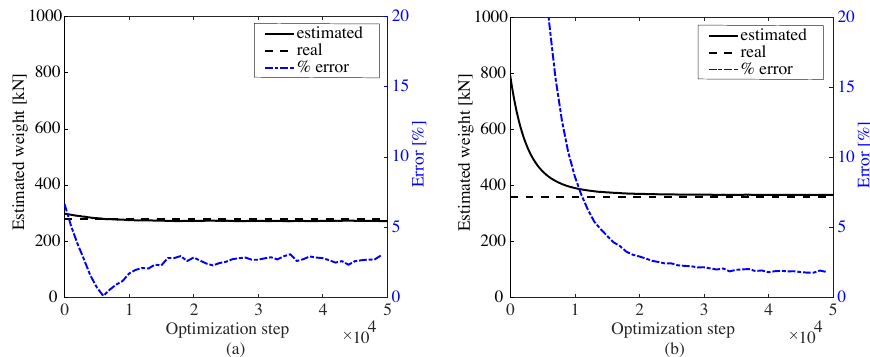
Figure 8. Weight estimations for the second simulation case; ( a ) type 1 truck; ( b ) type 2